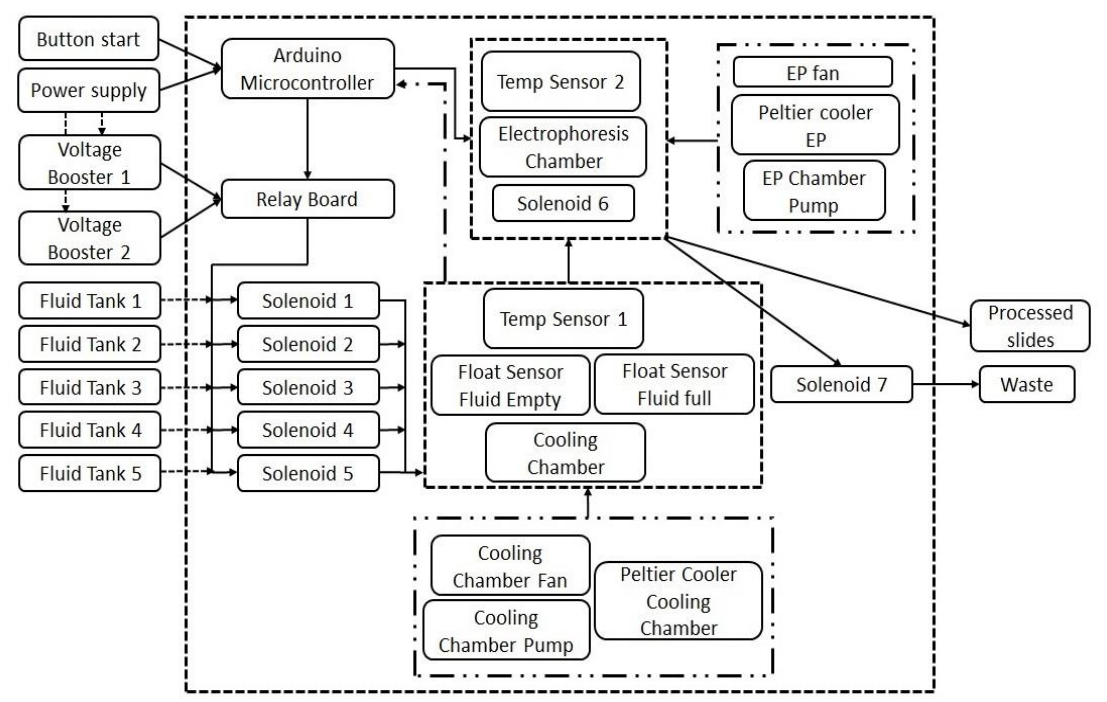
Figure 4. A schematic illustrating the key component of the AHT device.